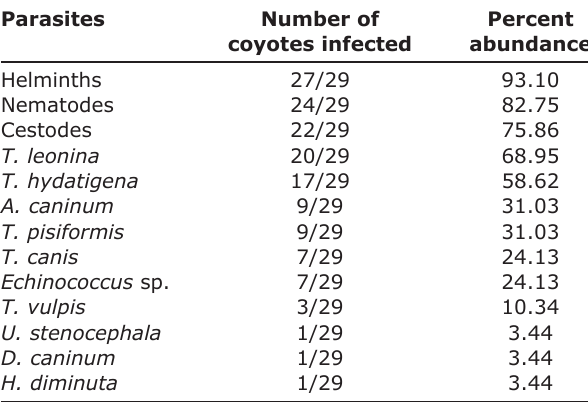
Table-2: The percent infection of coyotes with various helminths parasites. Parasites